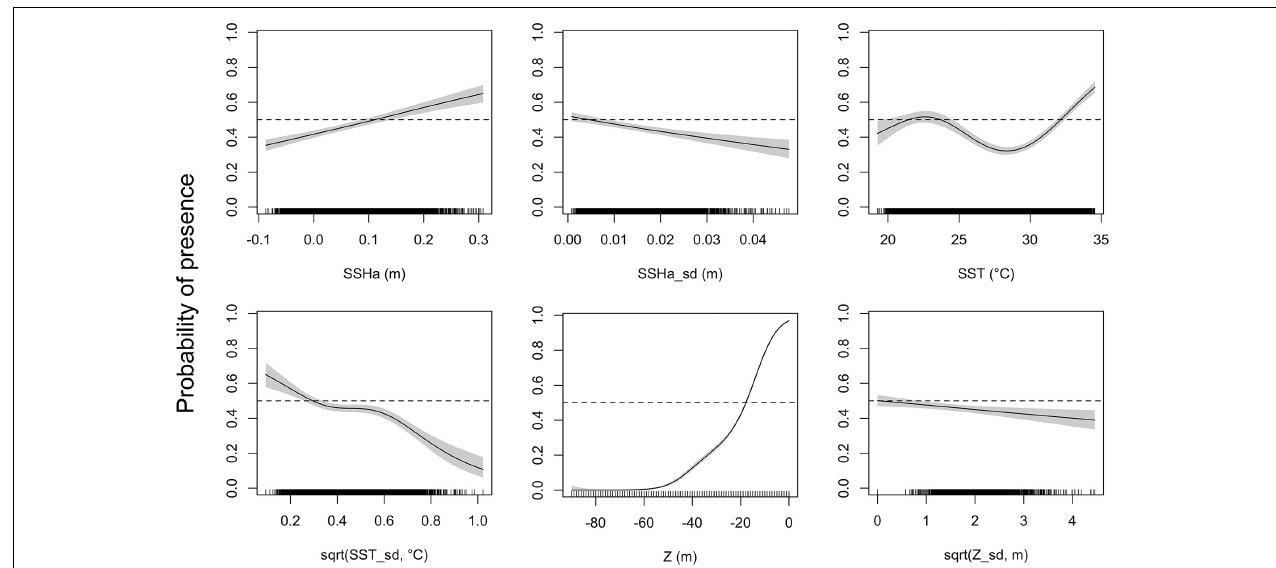
FIGURE 3 | Response curves of the presence-availability species distribution model as analyzed by a generalized additive mixed model (GAMM). Environmental covariates acronyms represent sea surface height anomaly (SSHa), SSHa standard deviation (SSHa_sd), sea surface temperature (SST), square-root transformation of SST standard deviation [sqrt(SST_sd)], depth (Z), and square-root transformation of Z standard deviation [sqrt(Z_sd)]. Shaded regions indicate the 95% confidence interval and tick marks on the bottom indicate all presence and pseudo-absence values for the environmental variable.